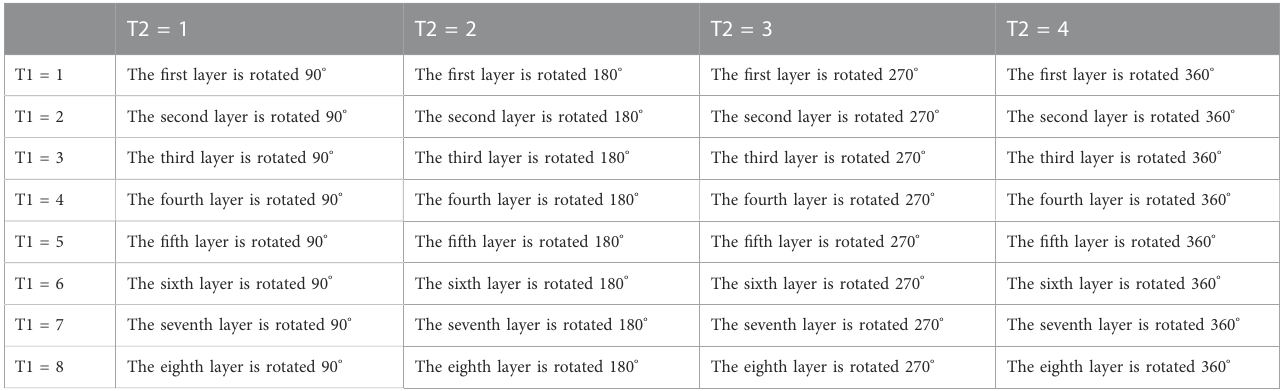
TABLE 1 Eighth-order Rubik ’ s cube rotation